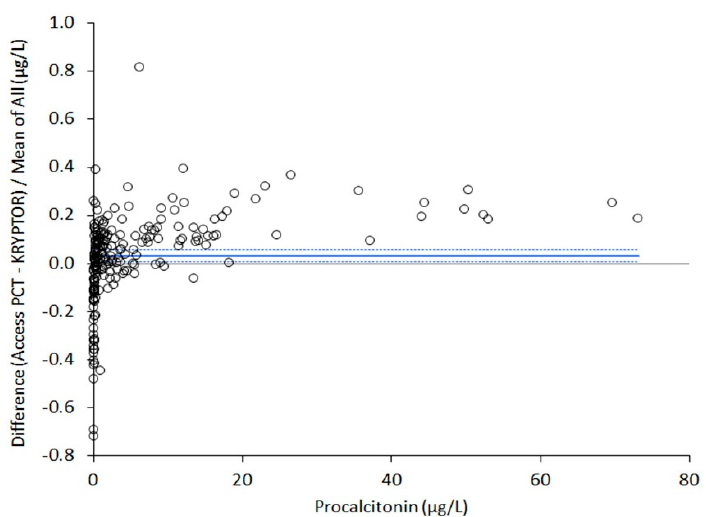
Figure 1. Bland–Altman plot analysis of procalcitonin (PCT) values obtained with Beckman Coulter Access PCT on the Access immunoassay system and BRAHMS PCT-sensitive Kryptor. The straight line defines the mean bias, whilst the dotted lines are drawn at the 95% confidence interval.